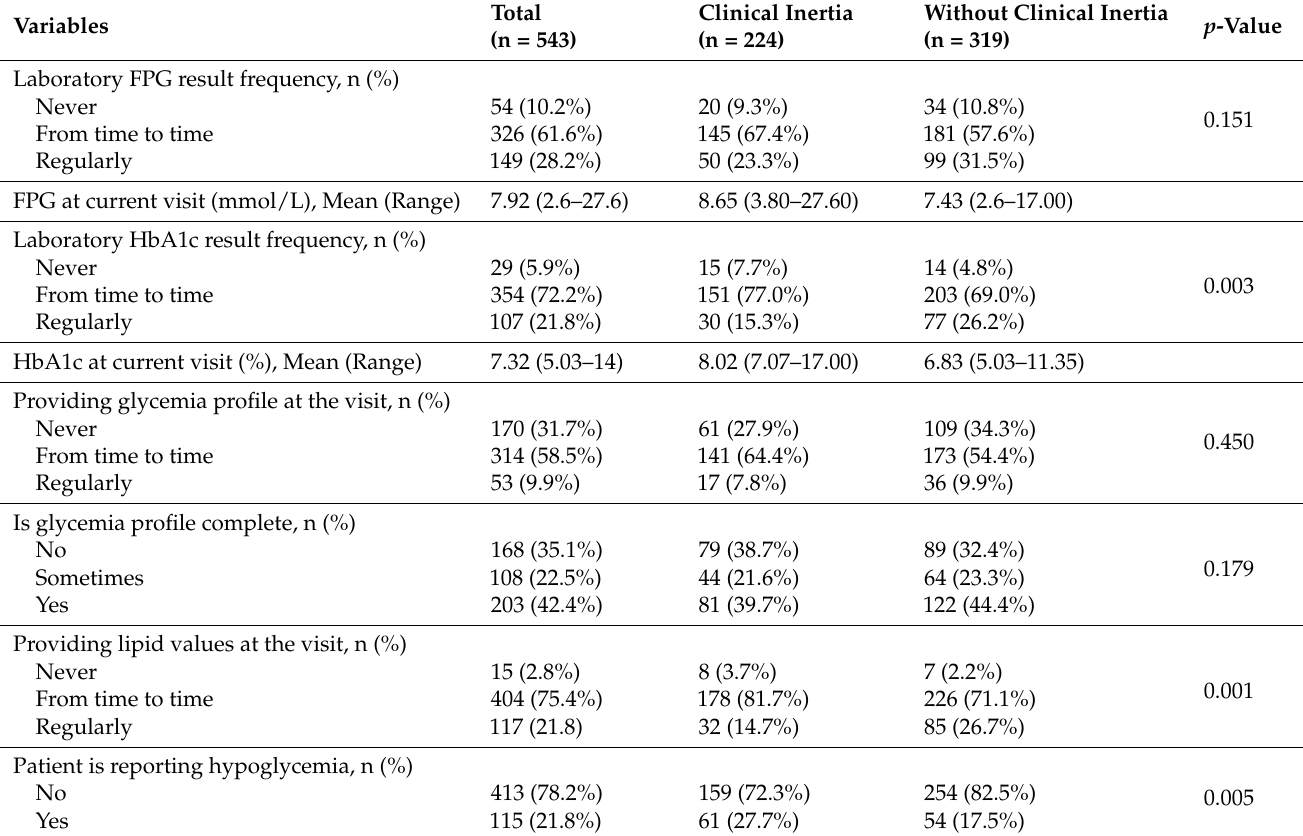
Table 4. Frequency of patients’ monitoring parameters and related clinical